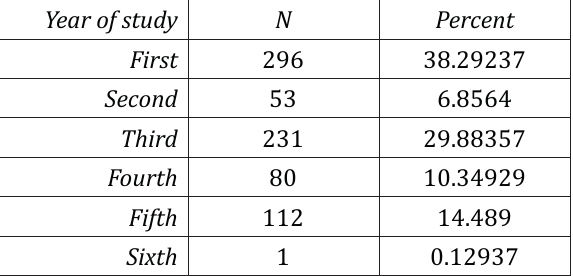
Table 1. The distribution of students for particular years of study